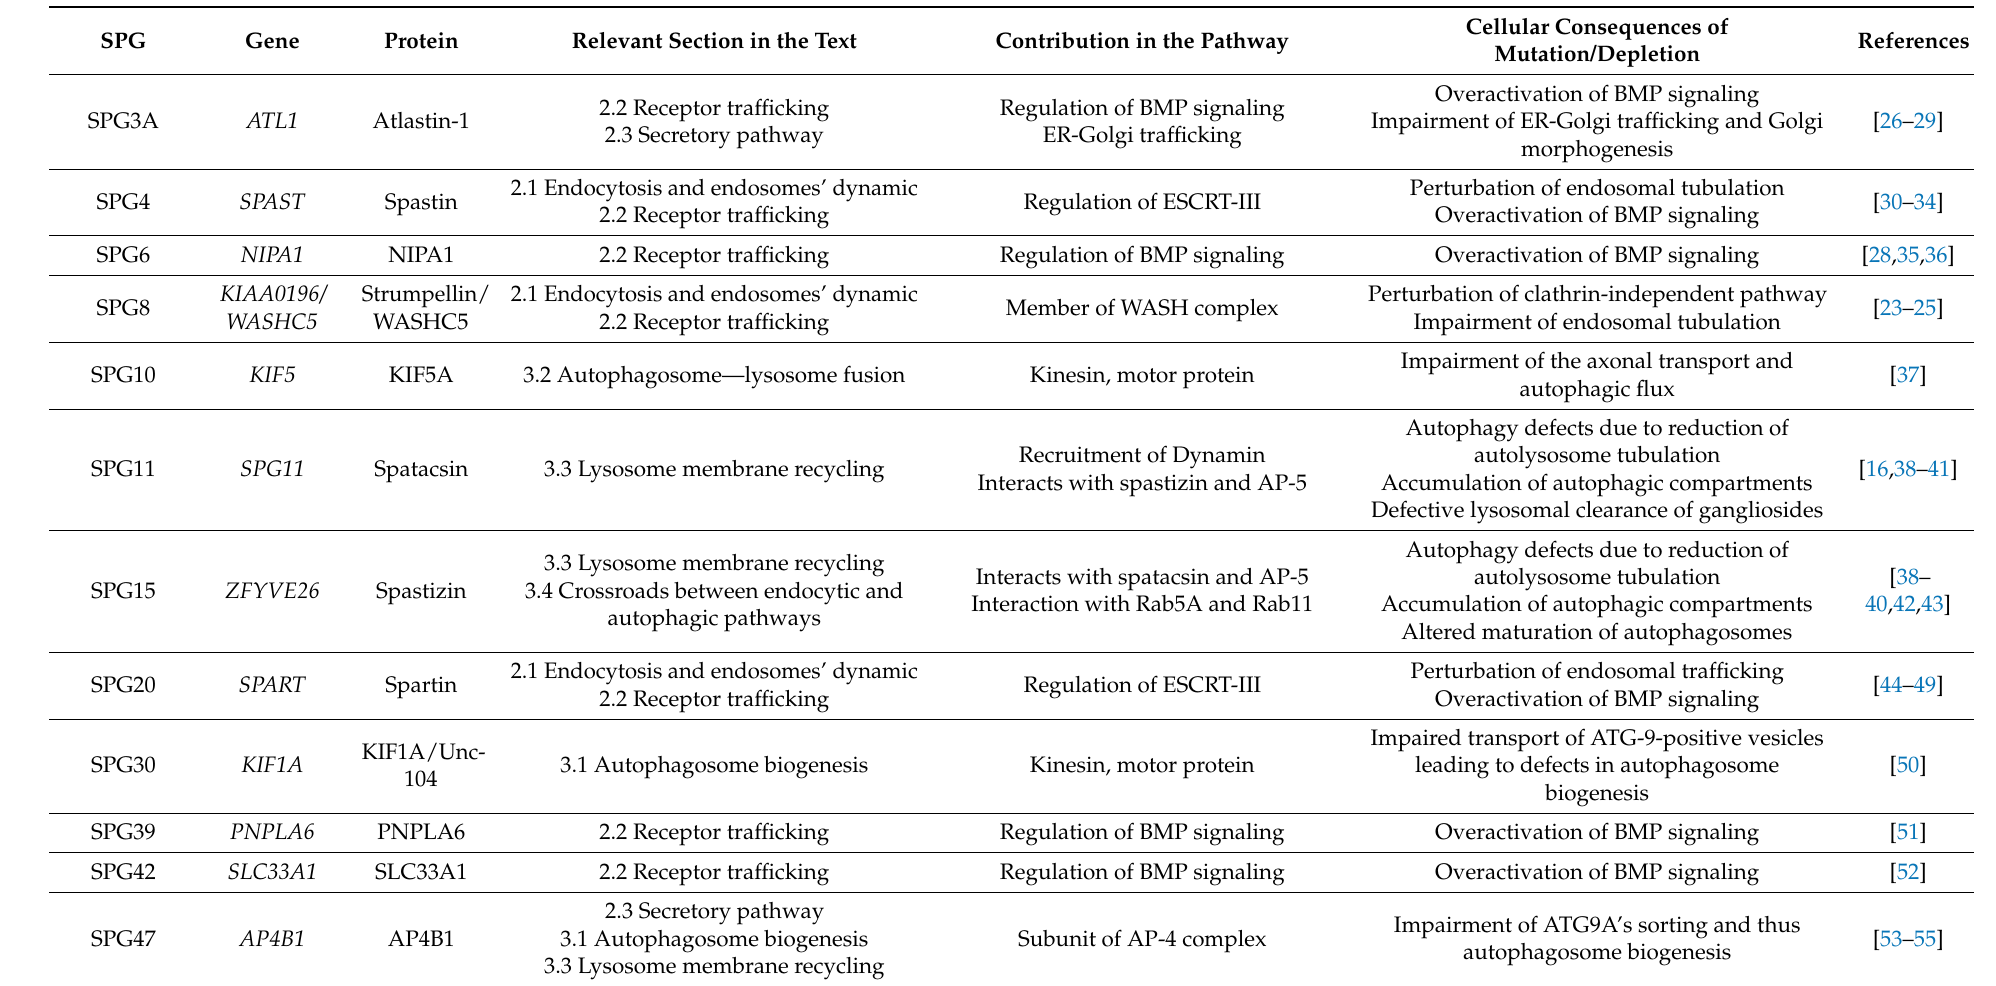
Table 1. HSP proteins involved in the endolysosomal system and autophagy. The cellular consequences mentioned here are only in the context of this review, and therefore only include the function of the protein in the endolysosomal and autophagic pathways. All the references to the SPG numbers and their clinical involvement can be found in Hedera et al. or Boutry et al.